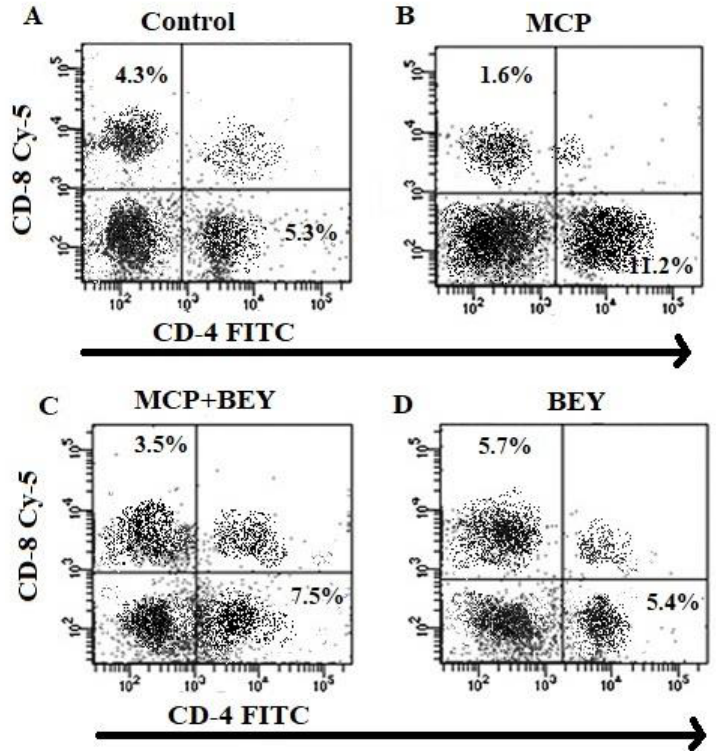
Figure 6. Flow cytometric analysis of T-cell population of EAE spleen was controlled by BEY supplementation. Reactivation of cell suspensions from the pooled spleen was carried out using MOG (10 µ g/mL) for 6 h. The frequencies of CD4 + and CD4 + were analyzed by FACS. ( A ) Control group cells. Representative FACS dots represented the frequency of CD4 + and CD4 + by CD65L differentiation in each group. The percentage of CD4 + and CD4 + T cells in each group was determined. ( B ) MCP-treated cells. ( C ). MCP-BEY-treated group. ( D ) BEY-alone-treated group. The data are representative of three independent experiments.